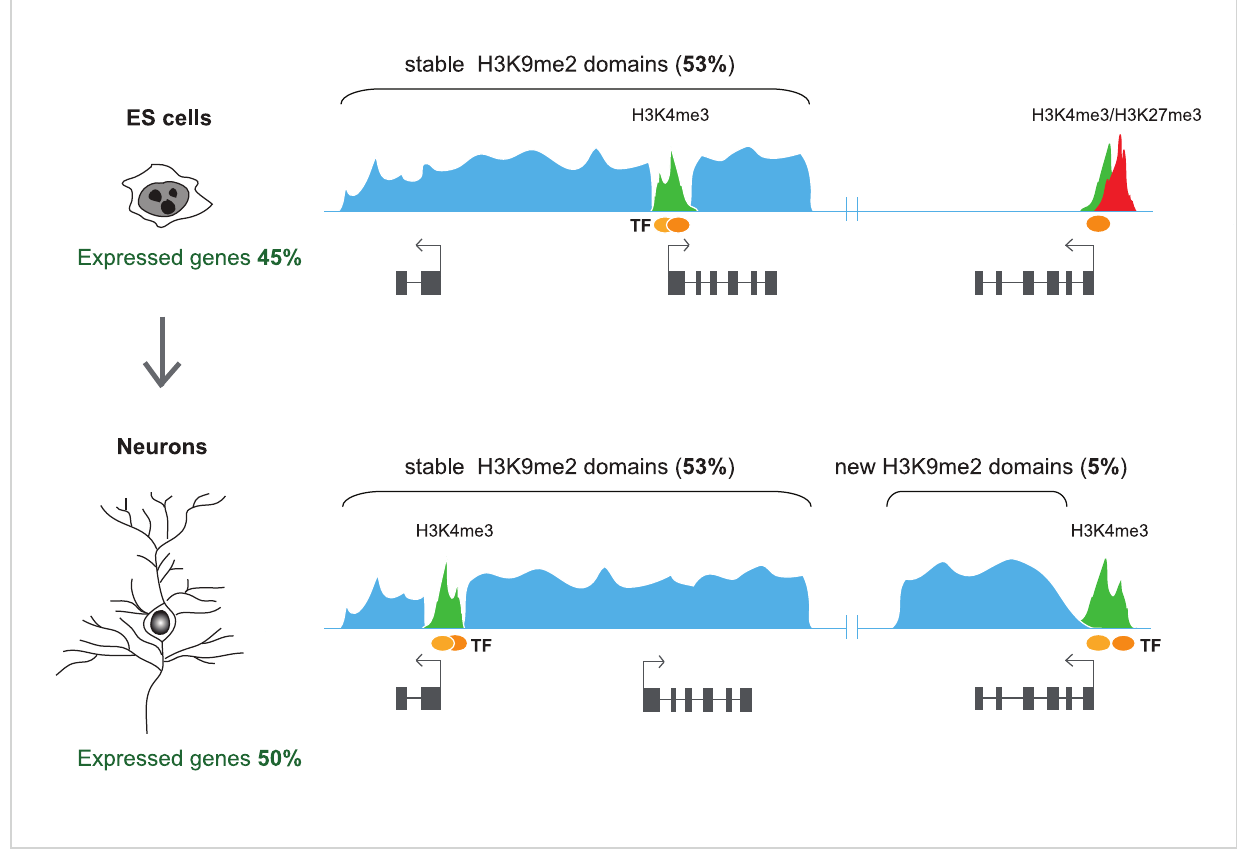
Figure 1. Chromatin landscapes in ES cells and terminally differentiated neurons. In ES cells, facultative heterochromatin domains marked by H3K9me2 (blue) cover a large proportion of the genome ( , 53%). Terminal differentiation of ES cells into pyramidal neurons in vitro is accompanied by net gain of H3K9me2 ( , 5%), mostly at new domains over the bodies of actively transcribed genes, and localized loss of H3K9me2 from much smaller regions. The focal loss of H3K9me2 could be induced by binding of specific transcription factors and modifiers (yellow/orange circles) to gene regulatory regions. Importantly, the overall size and distribution of stable H3K9me2 domains remain largely unchanged. Promoters carrying bivalent (active H3K4 [green] and repressive H3K27 [red]) marks are resolved into monovalent state during differentiation. Although different and very specific sets of genes are expressed in ES cells and neurons, the overall global transcriptional output of the genome is conserved.